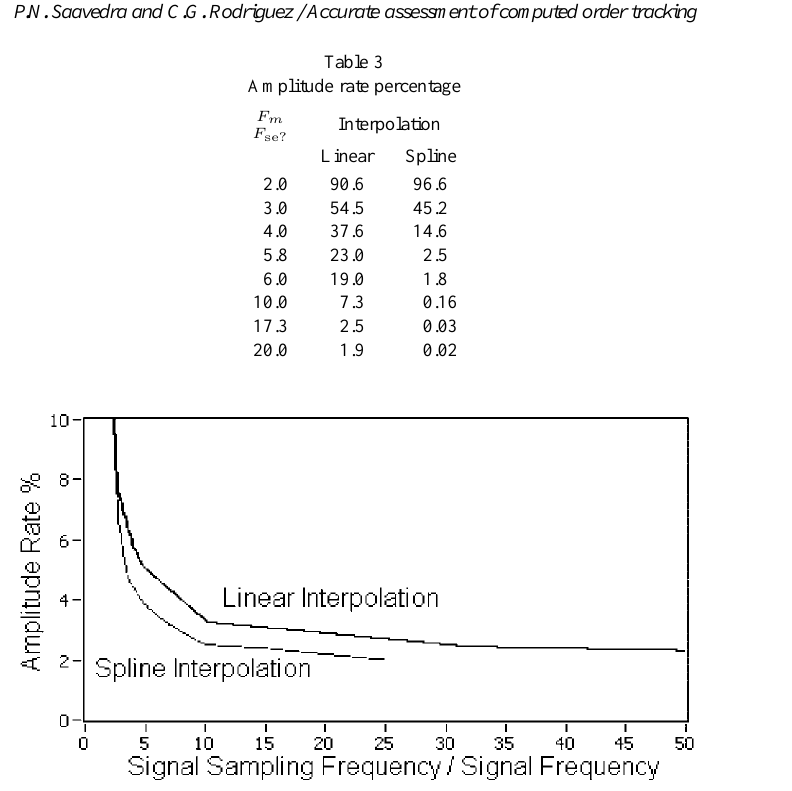
Fig. 19. Amplitude rate percentage for a pulse sampling frequency of 35.3 times the pulse